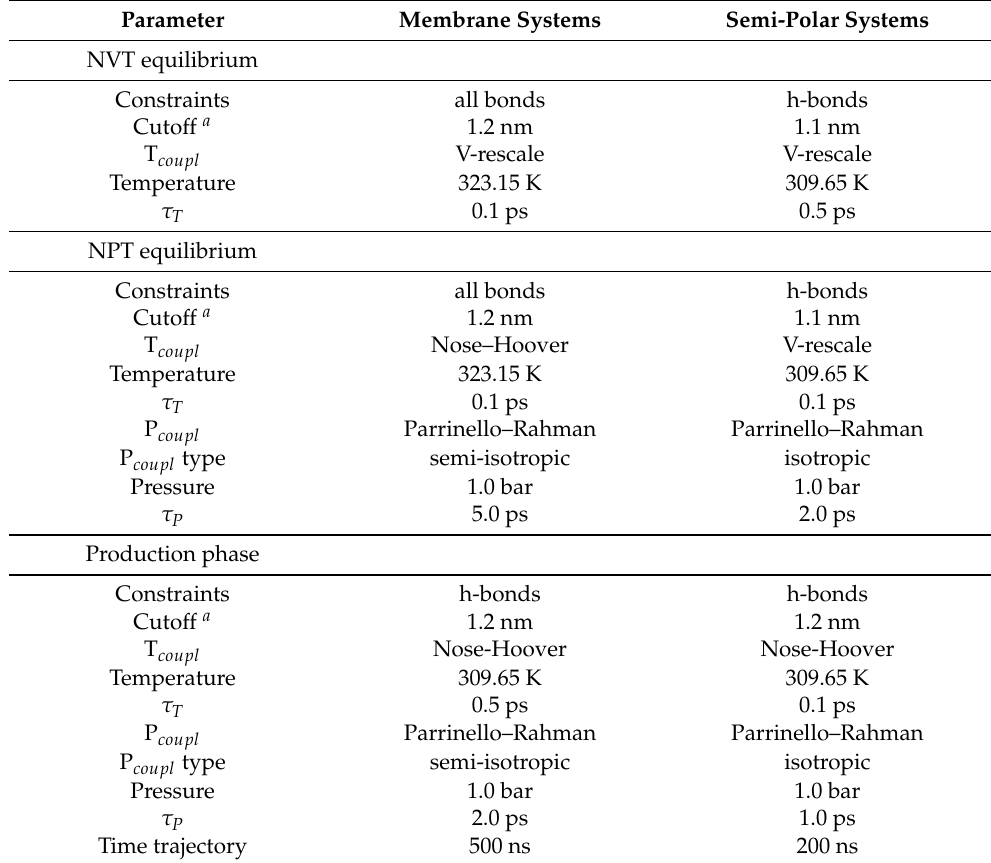
Table 1. MD simulation conditions used in this